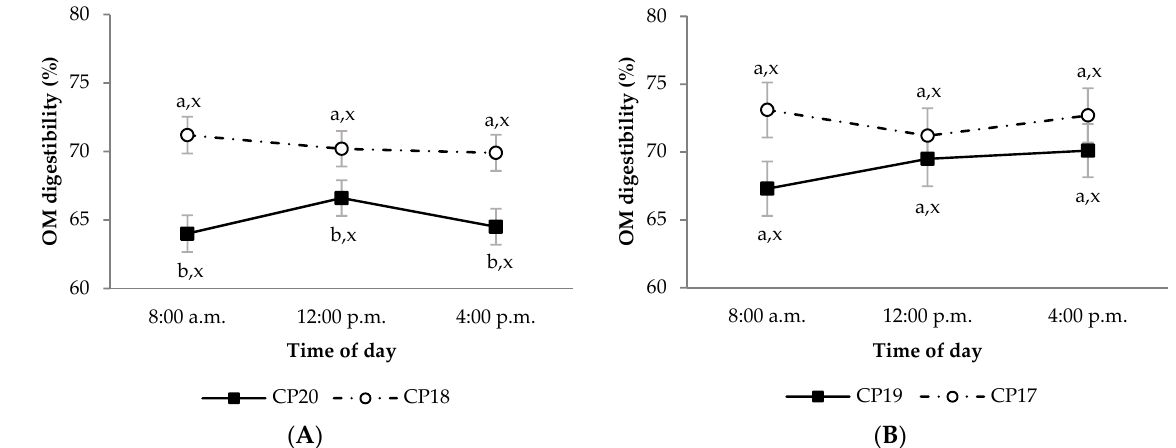
Figure 1. Digestibility of organic matter (OM) in growing ( A ) and finishing ( B ) periods in Ripollesa lambs fed with different concentrations of crude protein were compared between treatments (CP20 vs. CP18 and CP19 vs. CP17) and time of the day (least square mean values ± standard error). Within each sampling hour, different letters (a, b) denote statistical differences ( p ≤ 0.05) between dietary treatments. Within each dietary treatment, different letters (x, y) denote statistical differences ( p ≤ 0.05) between sampling hours.